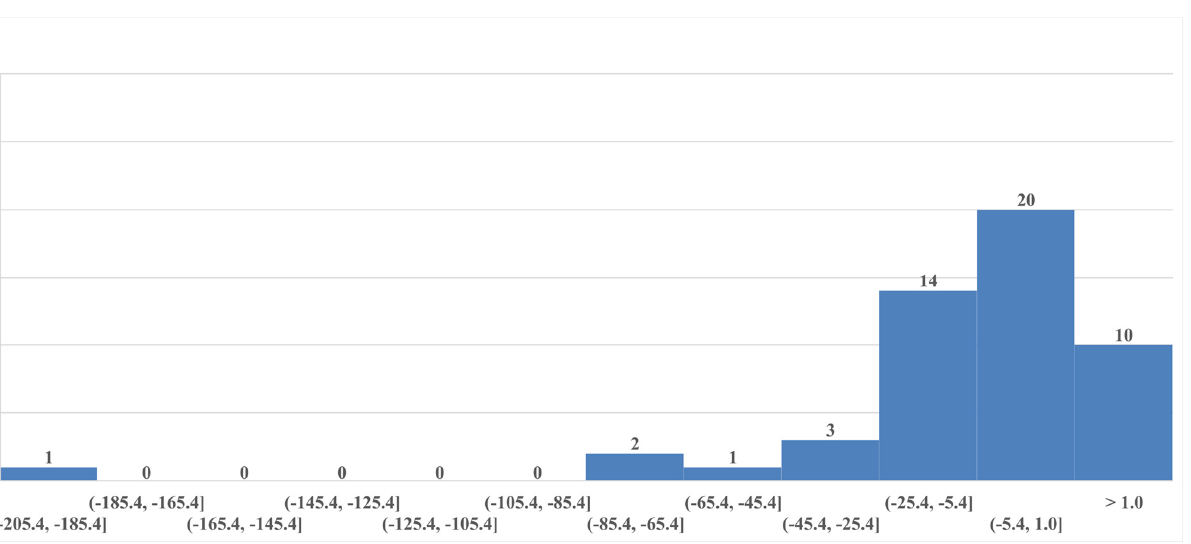
Figure 1. Number of OPs at distinct efficiency score subintervals.